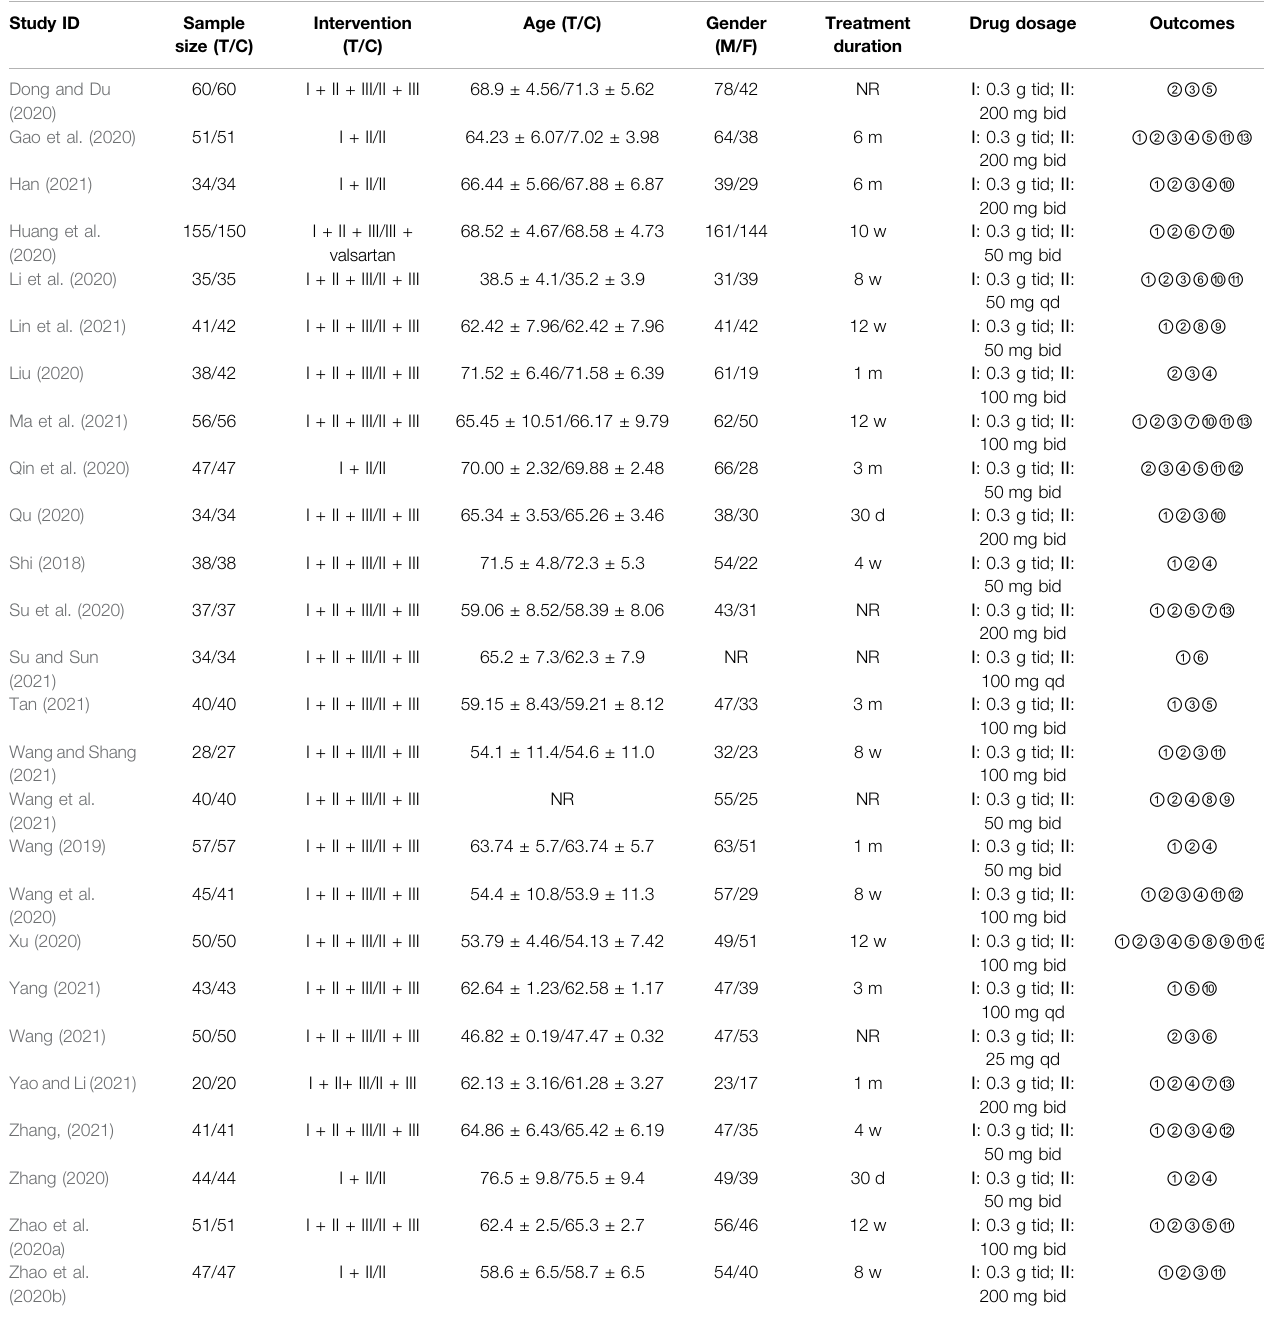
TABLE 1 | Characteristics of included